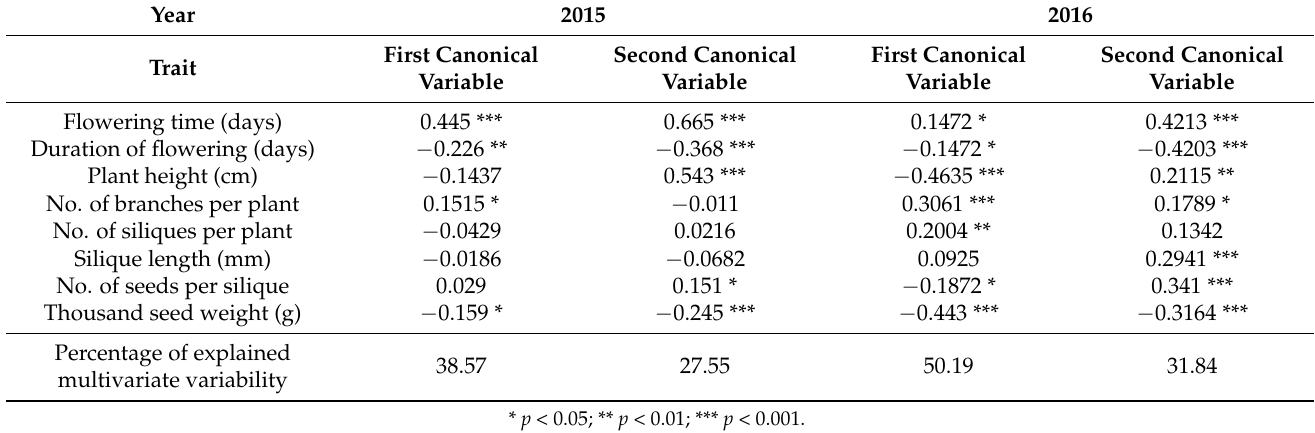
Table 1. Correlation coefficients between the first two canonical variates and observed traits in two years of study.